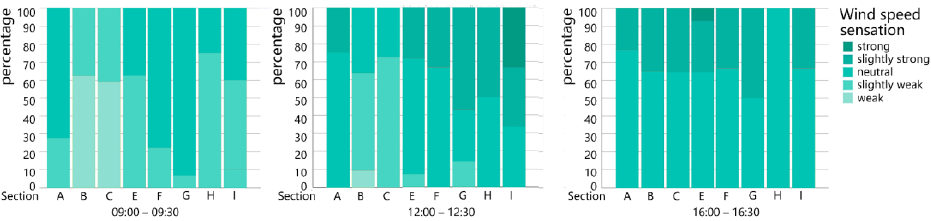
Figure A6. Wind speed sensation votes of the three time periods on 12 September.